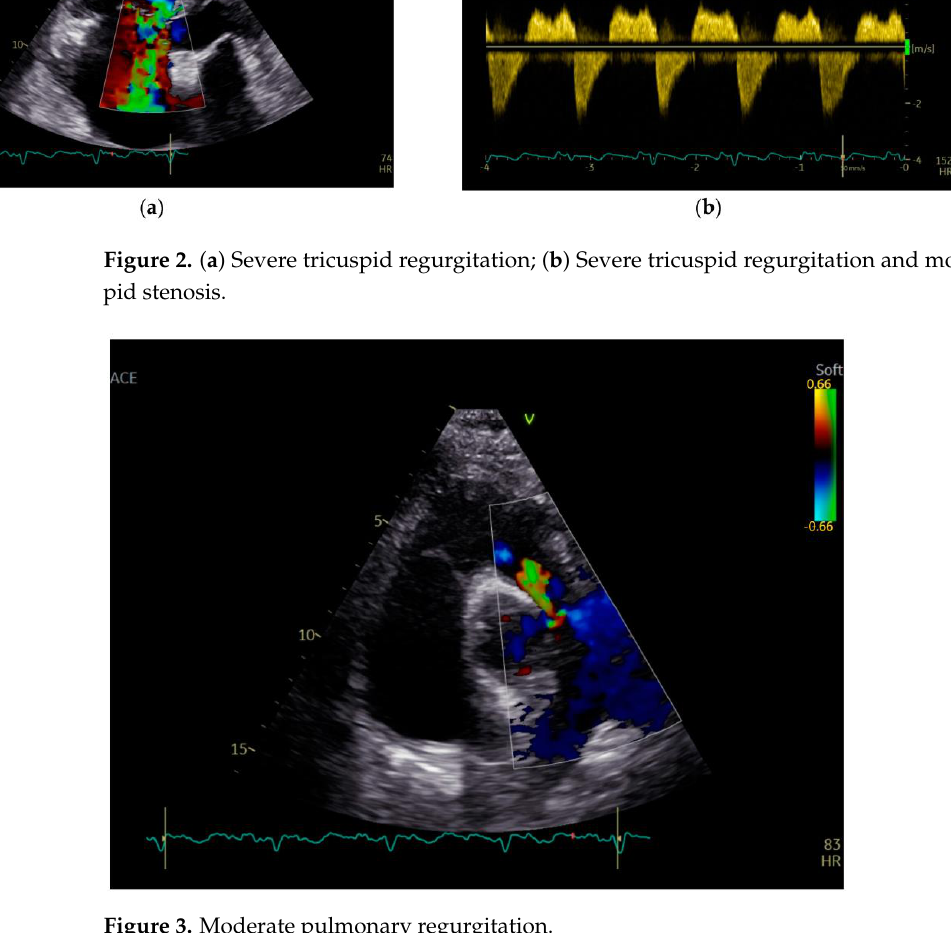
Figure 4. Atrial septal aneurysm.